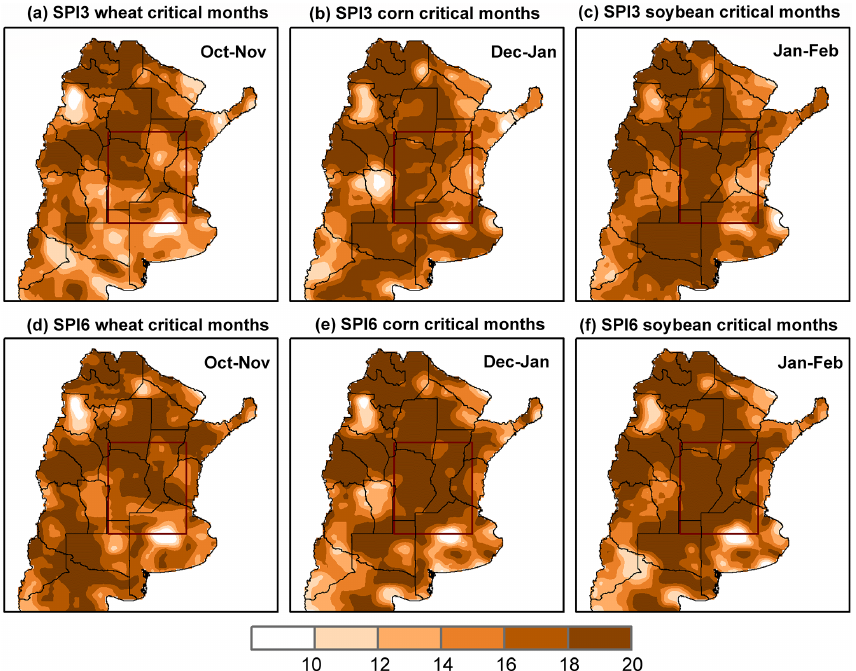
Figure 3. Percentage of months under moderate to extreme drought conditions (months below 1 standard deviation) during the crops’ critical growing months from January 1979 to December 2018. (a) Wheat during October–November, (b) corn during December–January, and (c) soybean during January–February for SPI3. Panels (d) – (f) are the same but for SPI6.